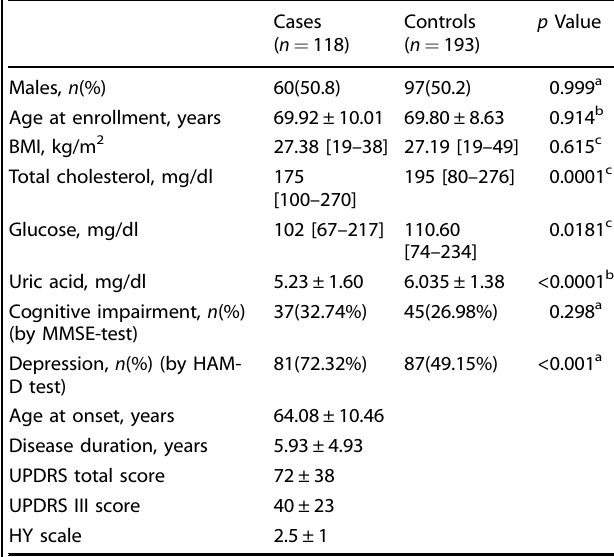
Table 1. Clinical and demographic characteristic of the study